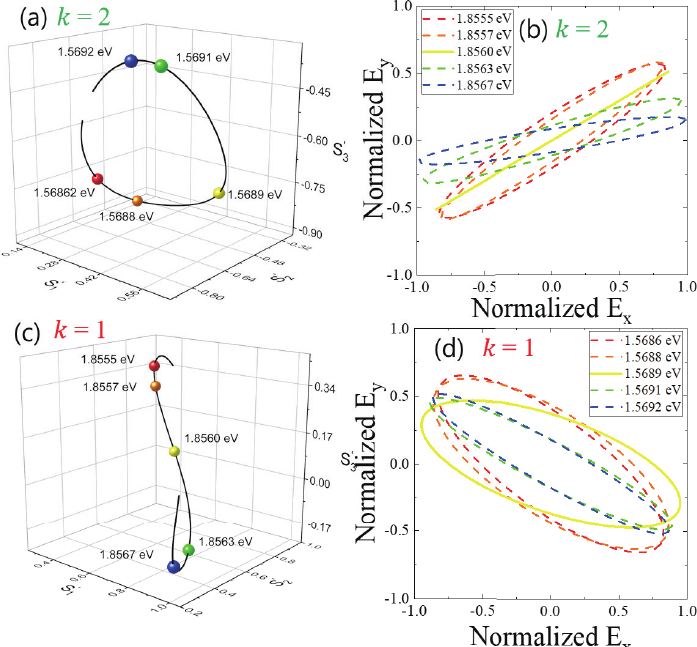
Figure 4. Various polarization states selected near the PL spectrum of the k = 2 state are plotted in Poincaré space ( a ), and the corresponding lateral elliptical polarization shapes are also shown in x - y coordinates ( b ). Normalized Stokes parameters according to different spectrum energy values in k = 2 state and k = 1 state are mapped on a Poincaré sphere, respectively. ( c , d ) For the k = 1 states, various elliptical polarization states selected at different spectrum energy values are also plotted in Poincaré space and x - y